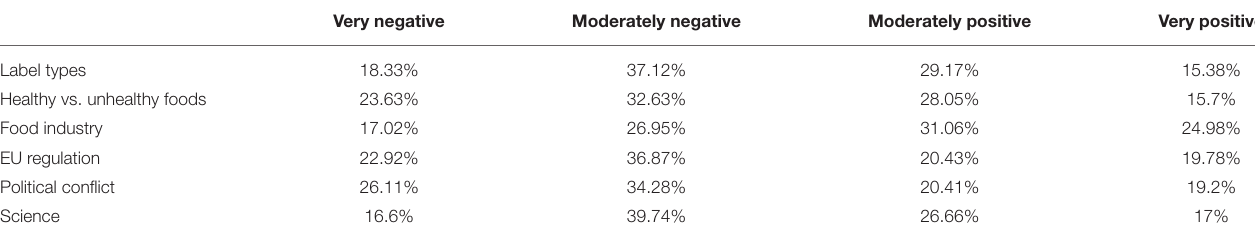
TABLE 2 | Sentiment analysis of